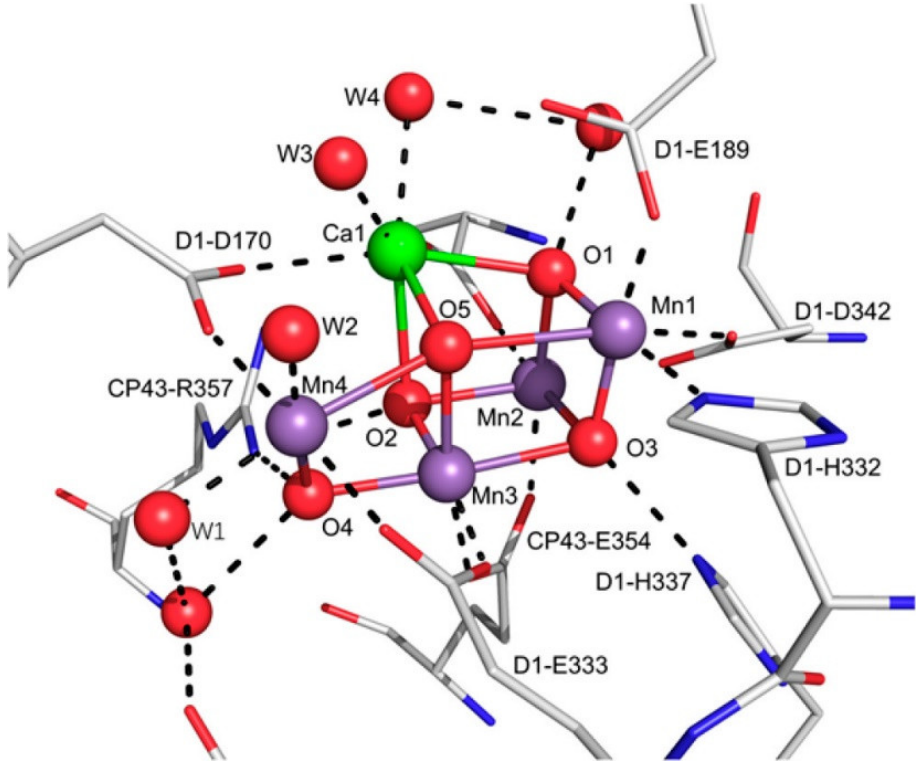
Figure 10. The active site structure of PS II. (Reprinted with permission from ref. [105] Copyright 2011 Nature Publishing Group and Wikipedia). Color code: C, grey; N, blue; O, white; Ca, green; Mn, violet;.